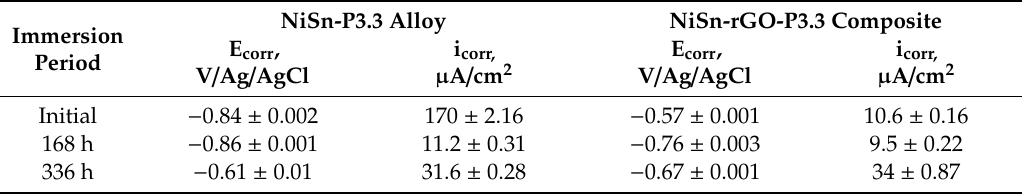
Figure 15. Polarization curves in semilogarithmic coordinates in 0.5 M NaCl for different periods of immersion (25 ◦ C, 5 mV s − 1 ). Table 6. Values of corrosion parameters resulting from polarization curves in 0.5 M NaCl for NiSn-P3.3 alloy and NiSn-rGO-P3.3 composite coatings after different conditioning periods.